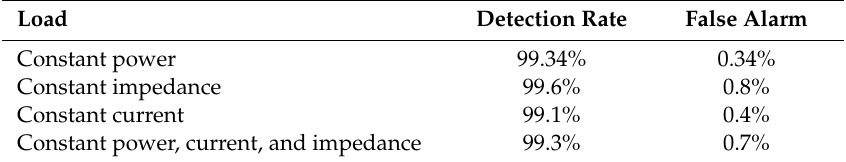
Table 6. Detection and false alarm rates for islanding classification with di ff erent loads.